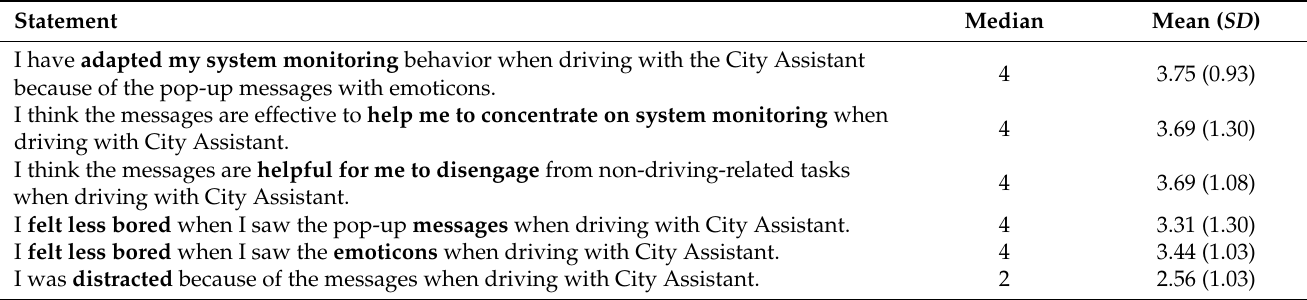
Table 6. Median and mean values of the AMC